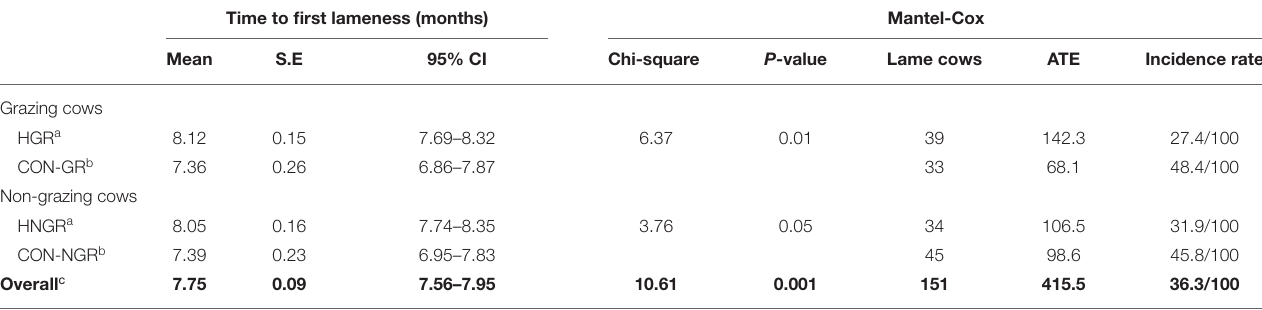
TABLE 3 | Time to first lameness event and lameness incidence rate in trimmed and control cows from grazing ( n = 2) and non-grazing ( n = 3) dairy farms. Time to first lameness (months) Mantel-Cox 95% CI Chi-square P -value Lame cows ATE Incidence rate Grazing